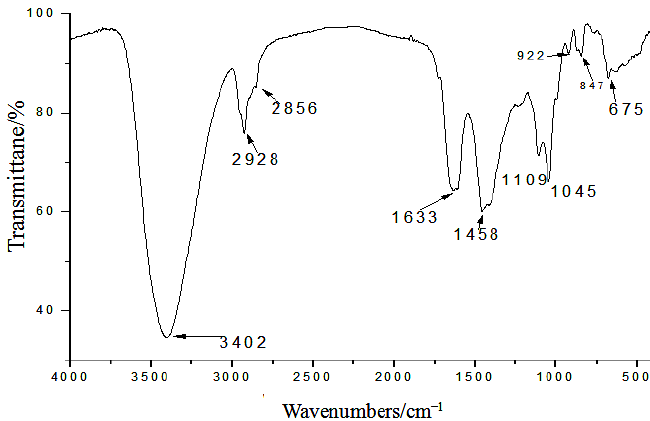
Figure 2. Infrared spectroscopy of Ganoderma lucidum polysaccharide